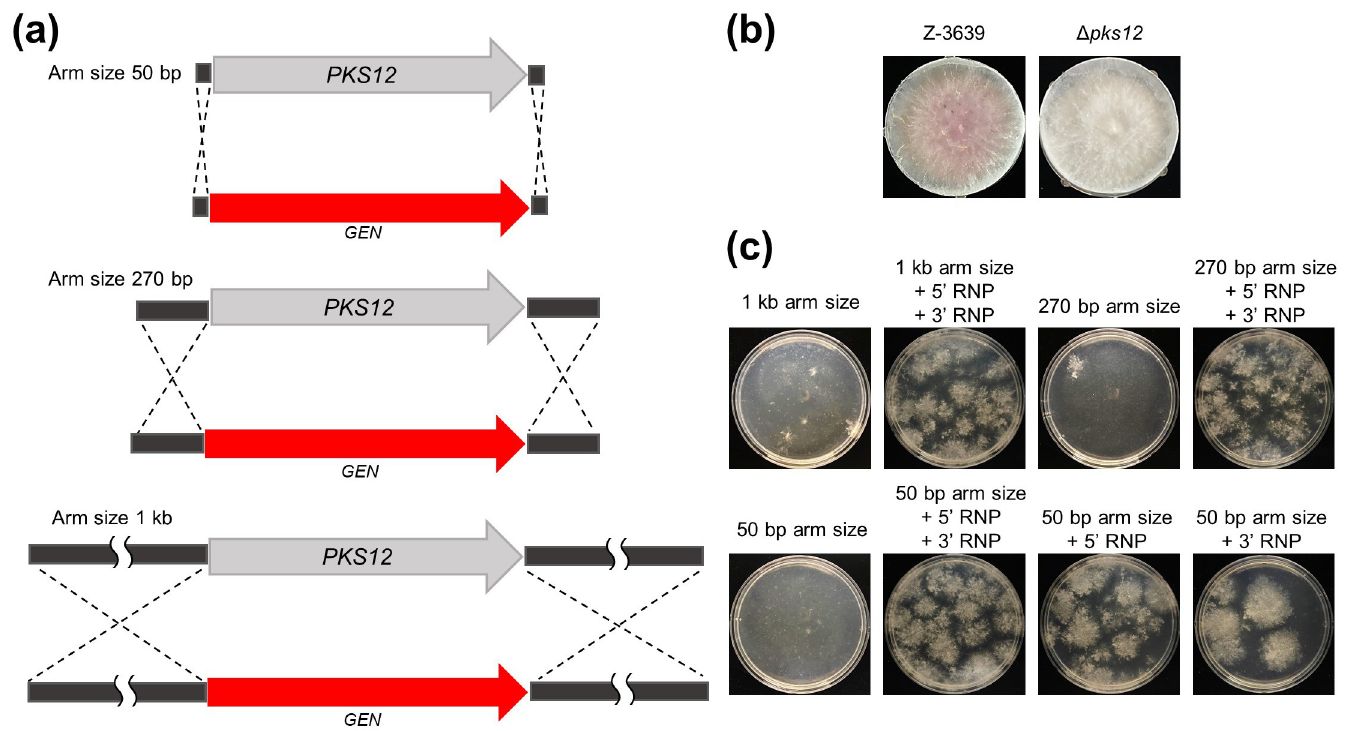
Fig 3. Construction of deletion mutants by Cas9 RNP-mediated transformation with different homology arm sizes. (a) Schematic representation of PKS12 deletion. Three constructs with different homology arm sizes (1 kb, 270 bp, and 50 bp) were generated for PKS12 deletion. (b) Colony morphologies of F . graminearum strains generated during Cas9 RNA-mediated transformation. (c) Each randomly chosen plate of disrupted phenotypes was counted as transformants in regeneration media. Expected phenotypes were later calculated as frequencies.